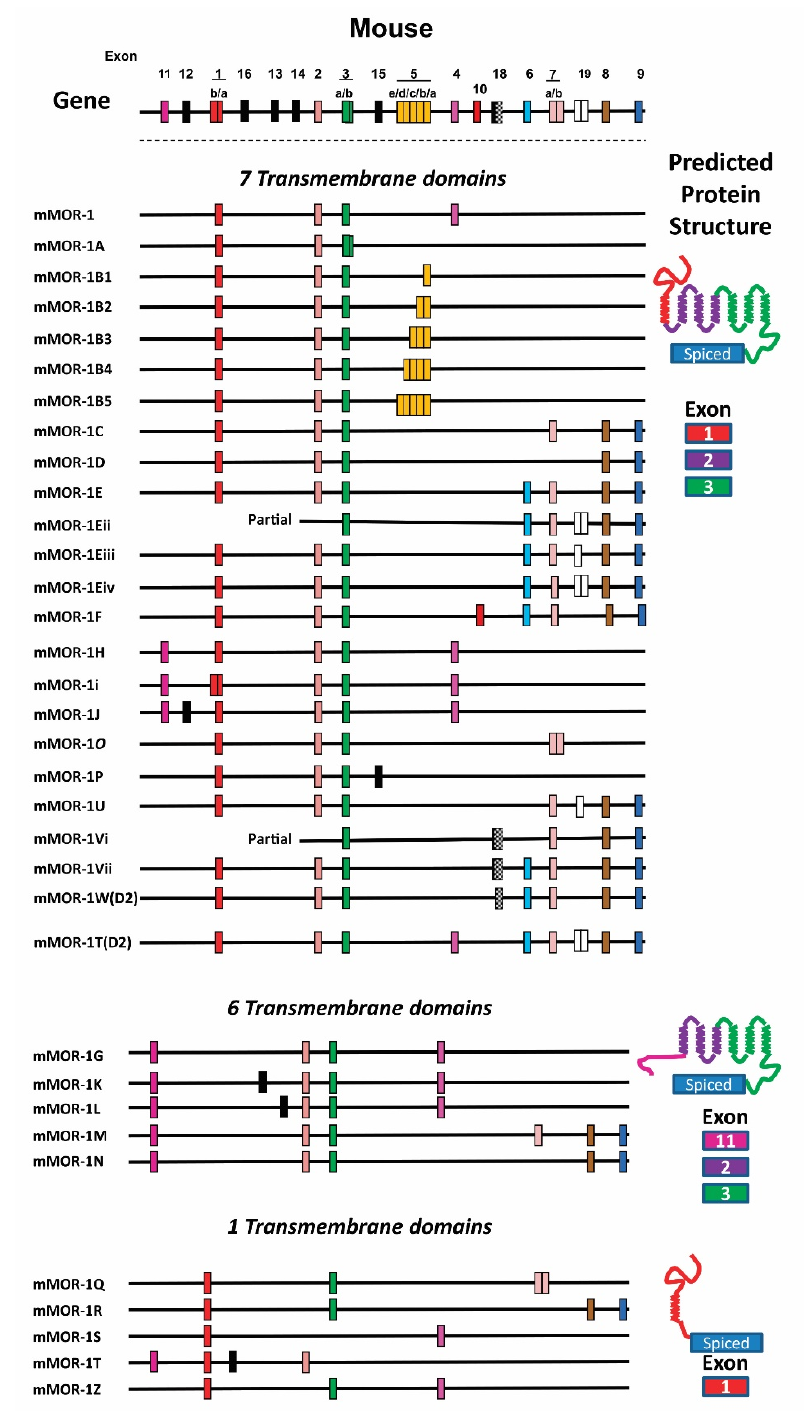
Figure 2. Schematic of the mouse Oprm1 gene structure and alternative splicing. The top panel is the Oprm1 gene structure. Alternatively spliced variants reported in the literature are grouped as 7TM, 6TM, and 1TM with predicted protein structure shown to the right and exon color coded to match the splicing schematic. From Pasternak and Pan 2013 [12] .